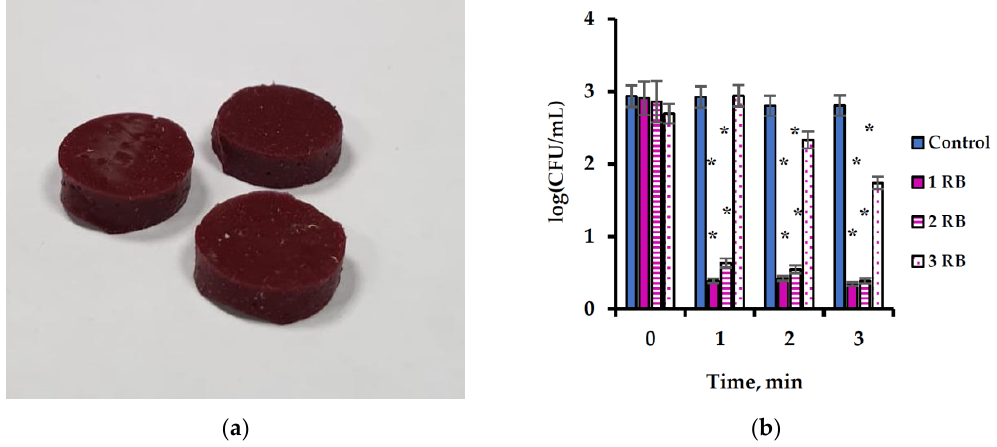
Figure 3. Photo of silicon tablets with immobilized Rose Bengal ( a ) and its antibacterial activity against S. aureus under ultrasonic activation in repeated applications ( b ). Designations: 1 RB — 1 st application of Rose Bengal; 2 RB — 2 nd application; and 3 RB — 3 rd application. Control — S. aureus cells treated by ultrasound only. Error bars present standard deviations. The asterisk ( * ) denotes statistically significant differences with the control ( p < 0.05).